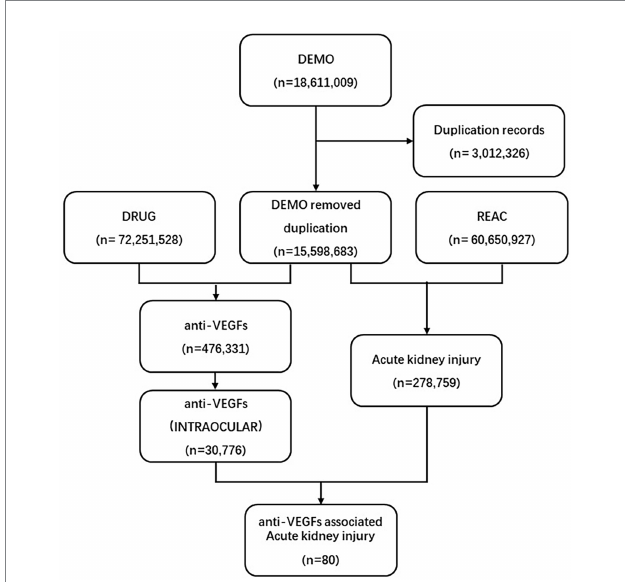
FIGURE 1 Process of the selection of cases of intravitreal anti-VEGF-associated renal adverse effects from the FAERS database. VEGF, vascular endothelial growth factor; FAERS, Food and Drug Administration’s Adverse Event